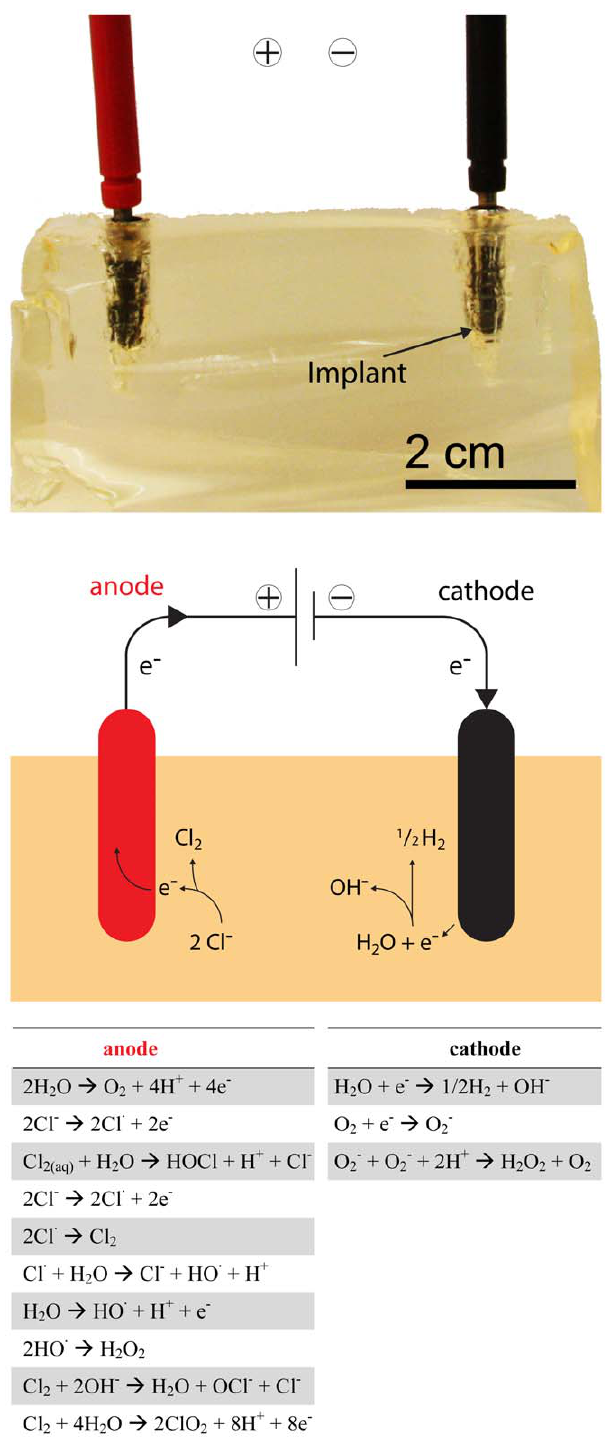
Figure 1. Simulated soft tissue (gelatin) with two dental implants. The anode (top, left) and cathode (top, right) were connected as part of an electric circuit powered by an external controller (top). The most probable reactions occurring at the electrodes are displayed in a scheme of the electrolysis setup to further illustrate the process (middle) and an overview (below) of the most likely occurring reactions is shown, too (adapted from [8,19]).